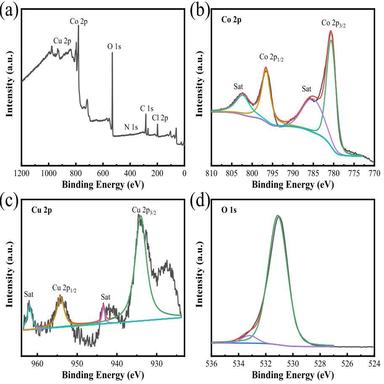
XPS spectra of the Cu-IM/Co-MOF: (a) survey, (b) Co 2p, (c) Cu 2p, and (d) O 1s.